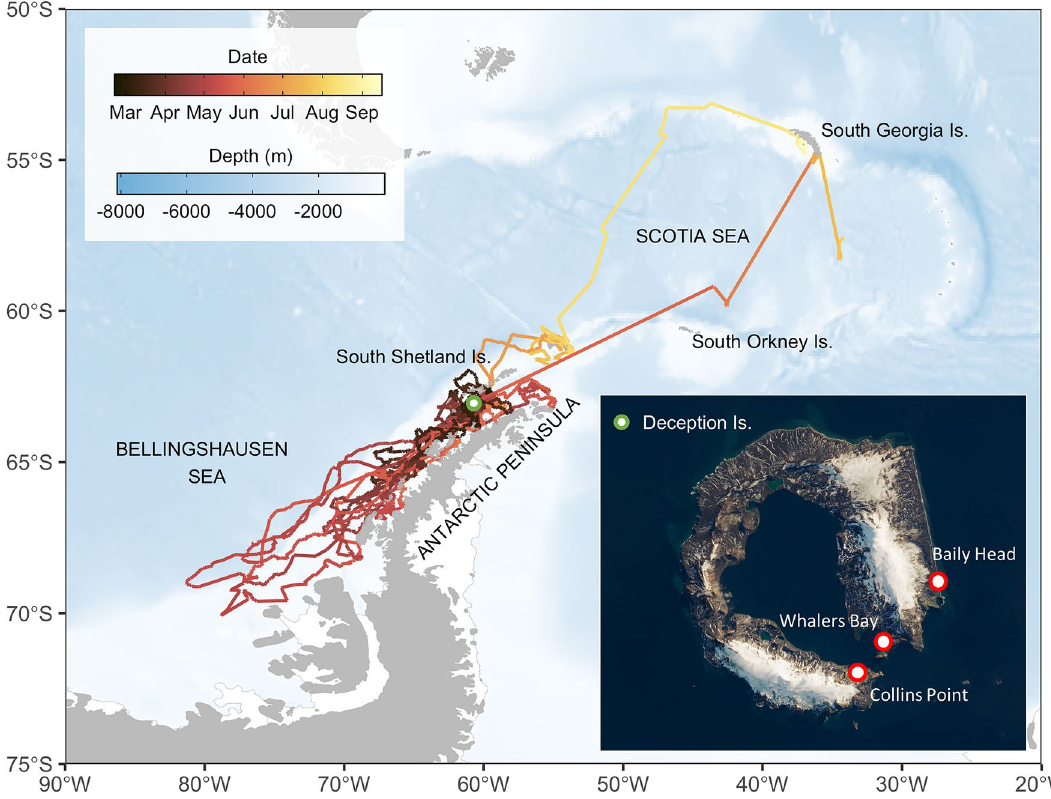
Figure 1. Study area and individual trajectories of juvenile and sub-adult male Antarctic fur seals. Deception Islands is denoted by the green symbol. Map inset shows the three haul-out locations where transect surveys were conducted at Deception Island (Satellite imagery from Landsat 8). Antarctic male fur seals were captured and instrumented at Collins Point. Map was generated using R version 4.0.2 (https:// www.r- proje ct. org/). NASA Earth Observatory image by Lauren Dauphin, using Landsat data from the U.S. Geological Survey.